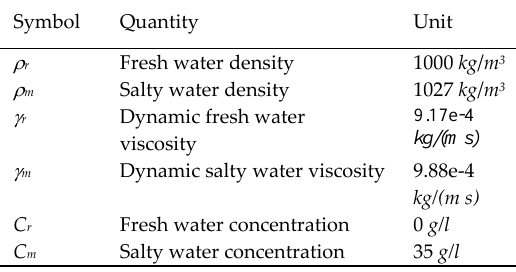
Fig. 7. Reactive power Q as function of hydraulic pressure ΔP h